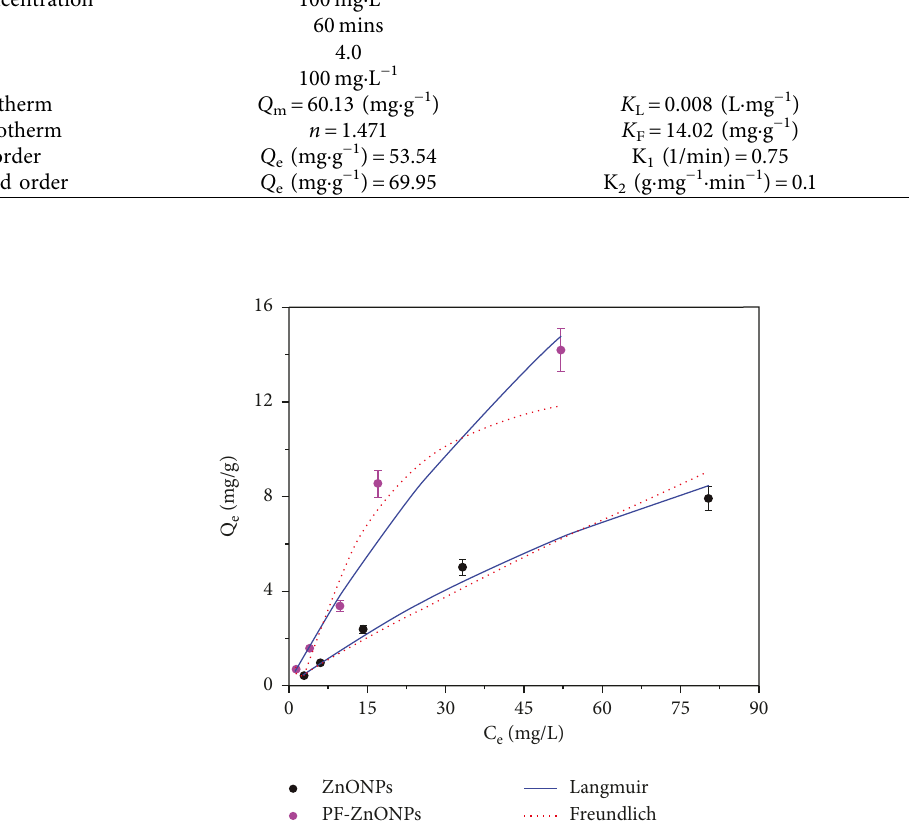
Figure 10: A plot of the Langmuir adsorption isotherm and the Freundlich adsorption isotherm of Cr (VI) on zinc oxide nanoparticles (ZnONPs) and plant-fabricated zinc oxide nanoparticles